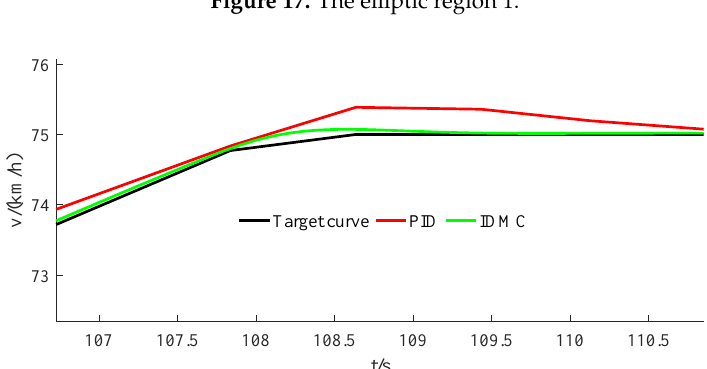
Figure 17. The elliptic region 1.